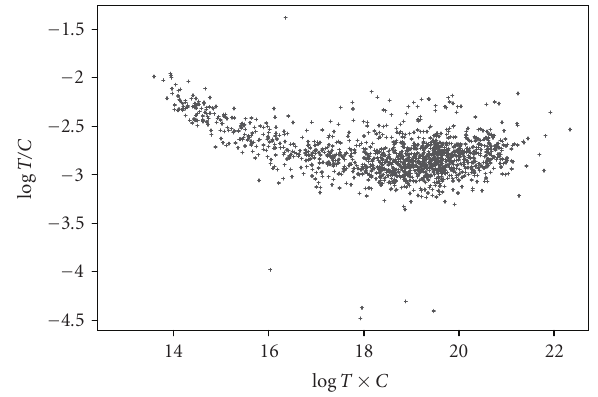
Figure 2: Intensity e ff ect: the estimated loess fit (red line) using the log T/C as the response with log T × C as the explanatory